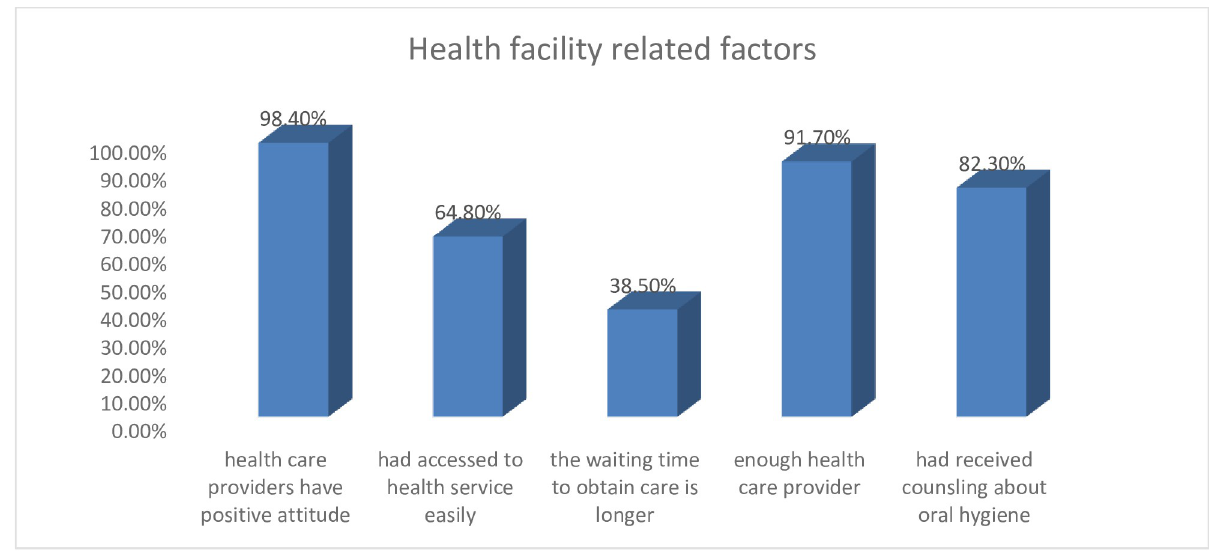
Fig 2. Health facility related factors associated with knowledge of pregnant mothers attending antenatal care in South Omo Zone hospitals, Southern Ethiopia, 2021.